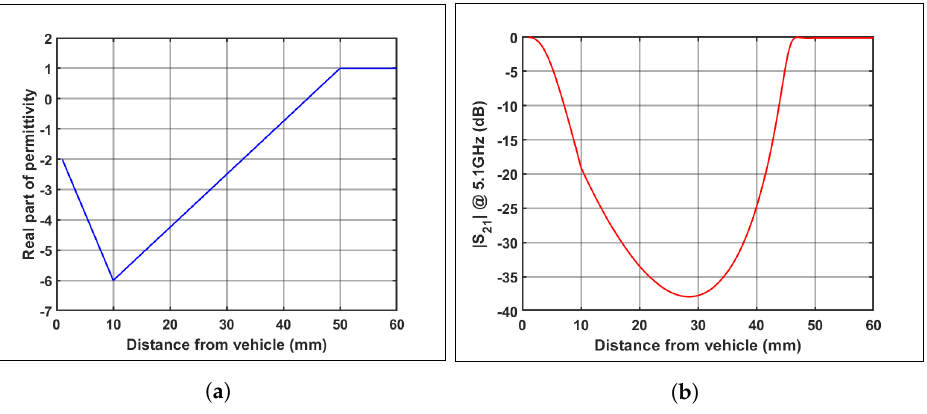
Figure 19. Transmission through a plasma region with varying plasma density. ( a ) Permittivity profile. ( b ) Transmission coefficient at the 5.1 GHz operating